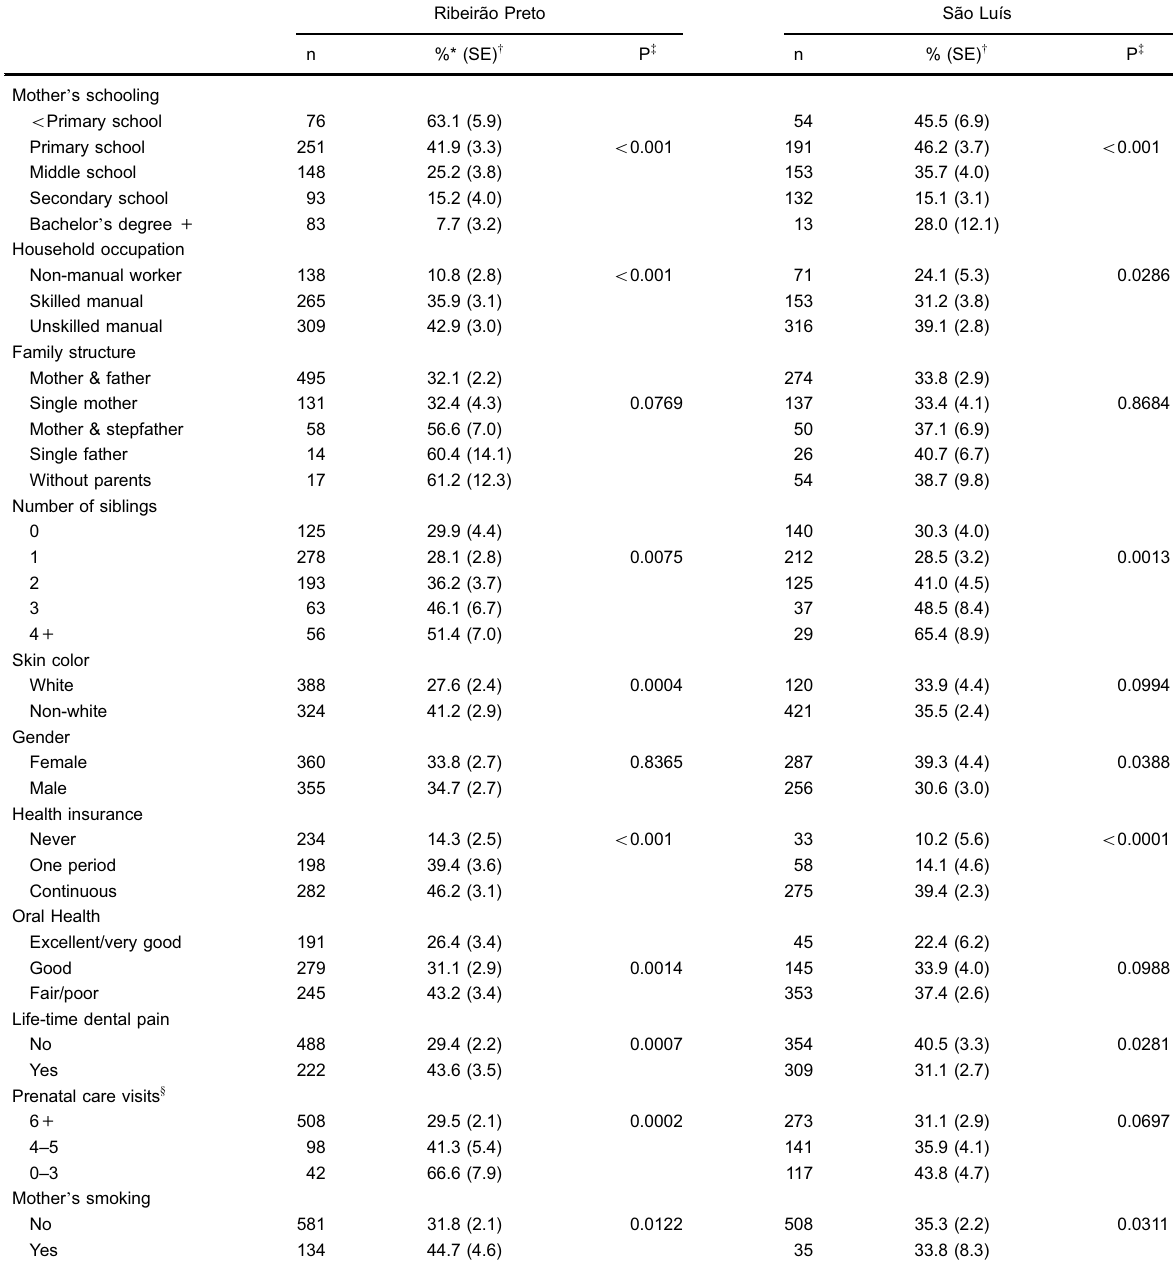
Table 2. Bivariate analysis results for children who had not seen a dentist before the age of 7 in the Ribeirão Preto and São Luís cohorts. Ribeirão Preto São